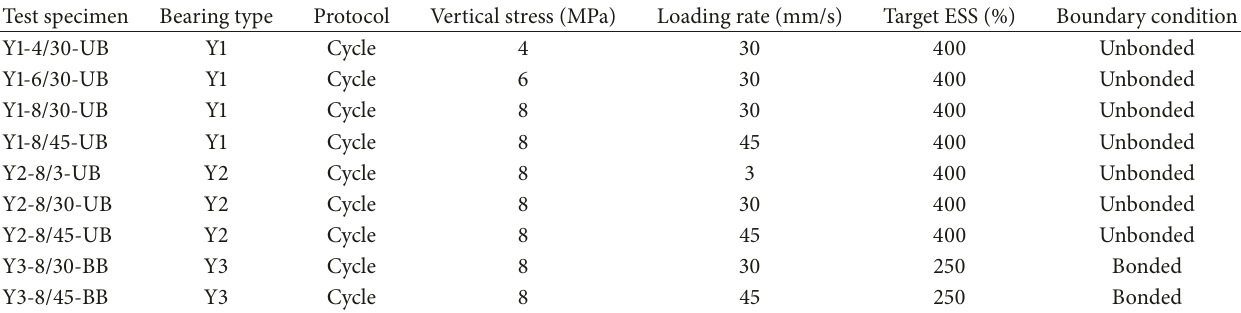
Table 2: Testing